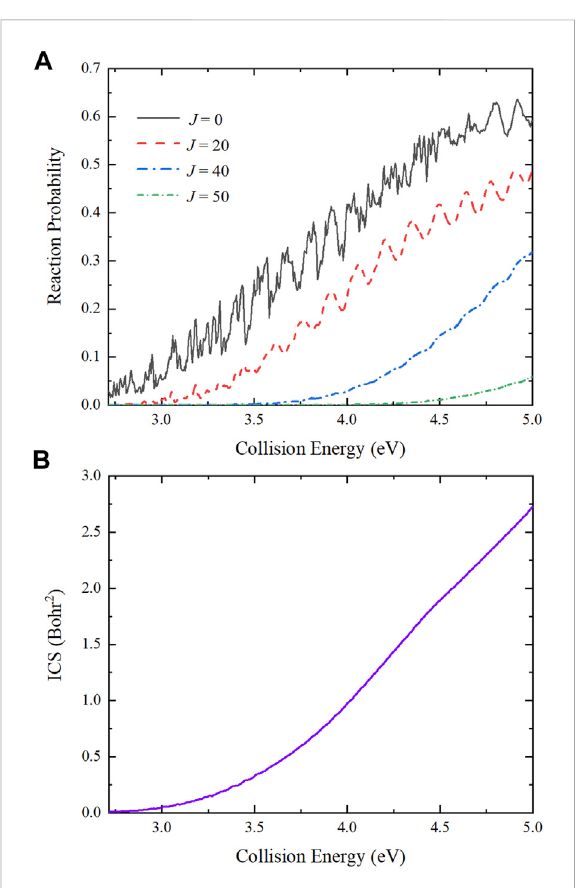
FIGURE 7 Collision energy dependence of (A) total reaction probabilities with four partial waves ( J = 0, 20, 40 and 50) and (B) total ICS of the Be( 1 S) + H 2 ( v 0 = 0, j 0 = 0) → BeH + H reaction calculated by the TDWP method on the ground-state BeH 2